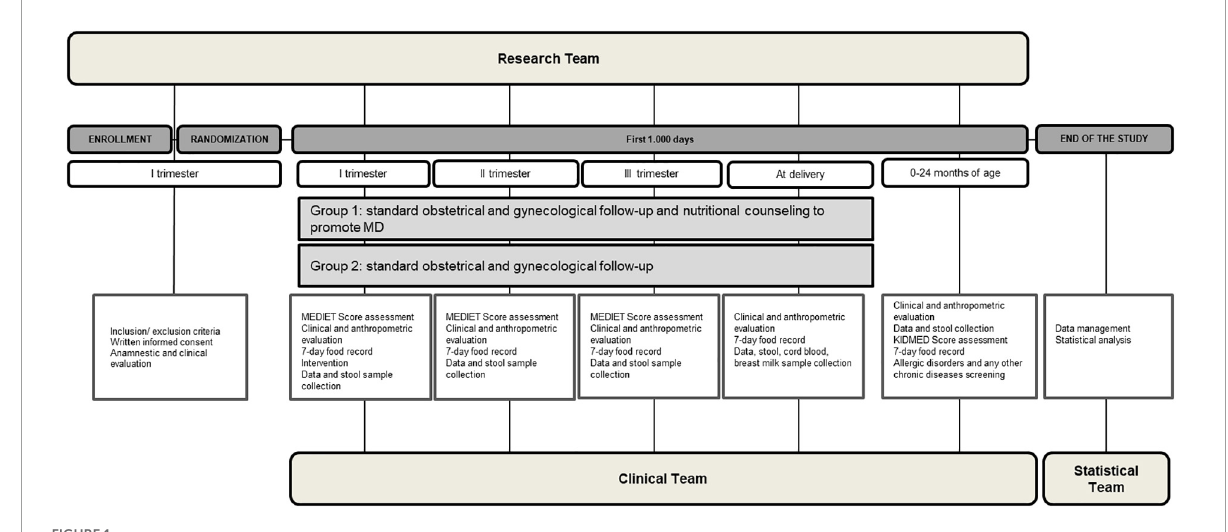
FIGURE1 The study design. The figure shows a graphical representation of the study design, including the set of procedures at each study visit, and including the execution team.